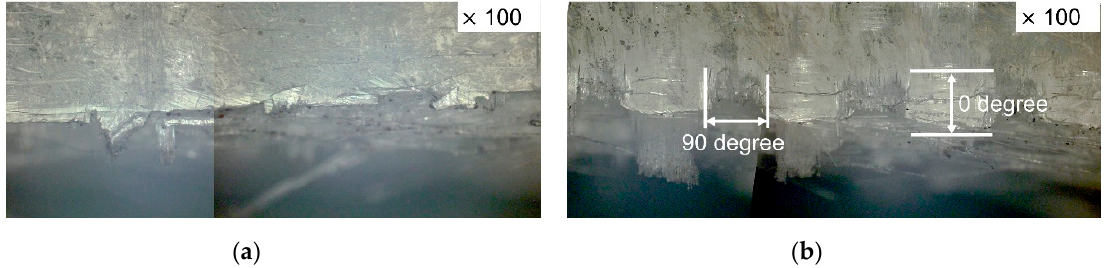
Figure 6. Photographs of fractured specimens subjected to ultraviolet exposure for ( a ) 0 h and ( b ) 300 h.